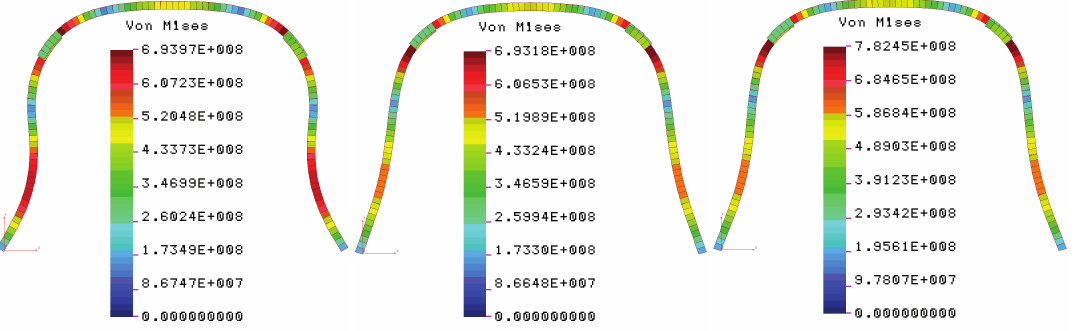
Figure 14: Map of reduced stresses in A (left), B (middle) and C (right) frames for load scheme – variant III (stresses in Pa, deformation scale